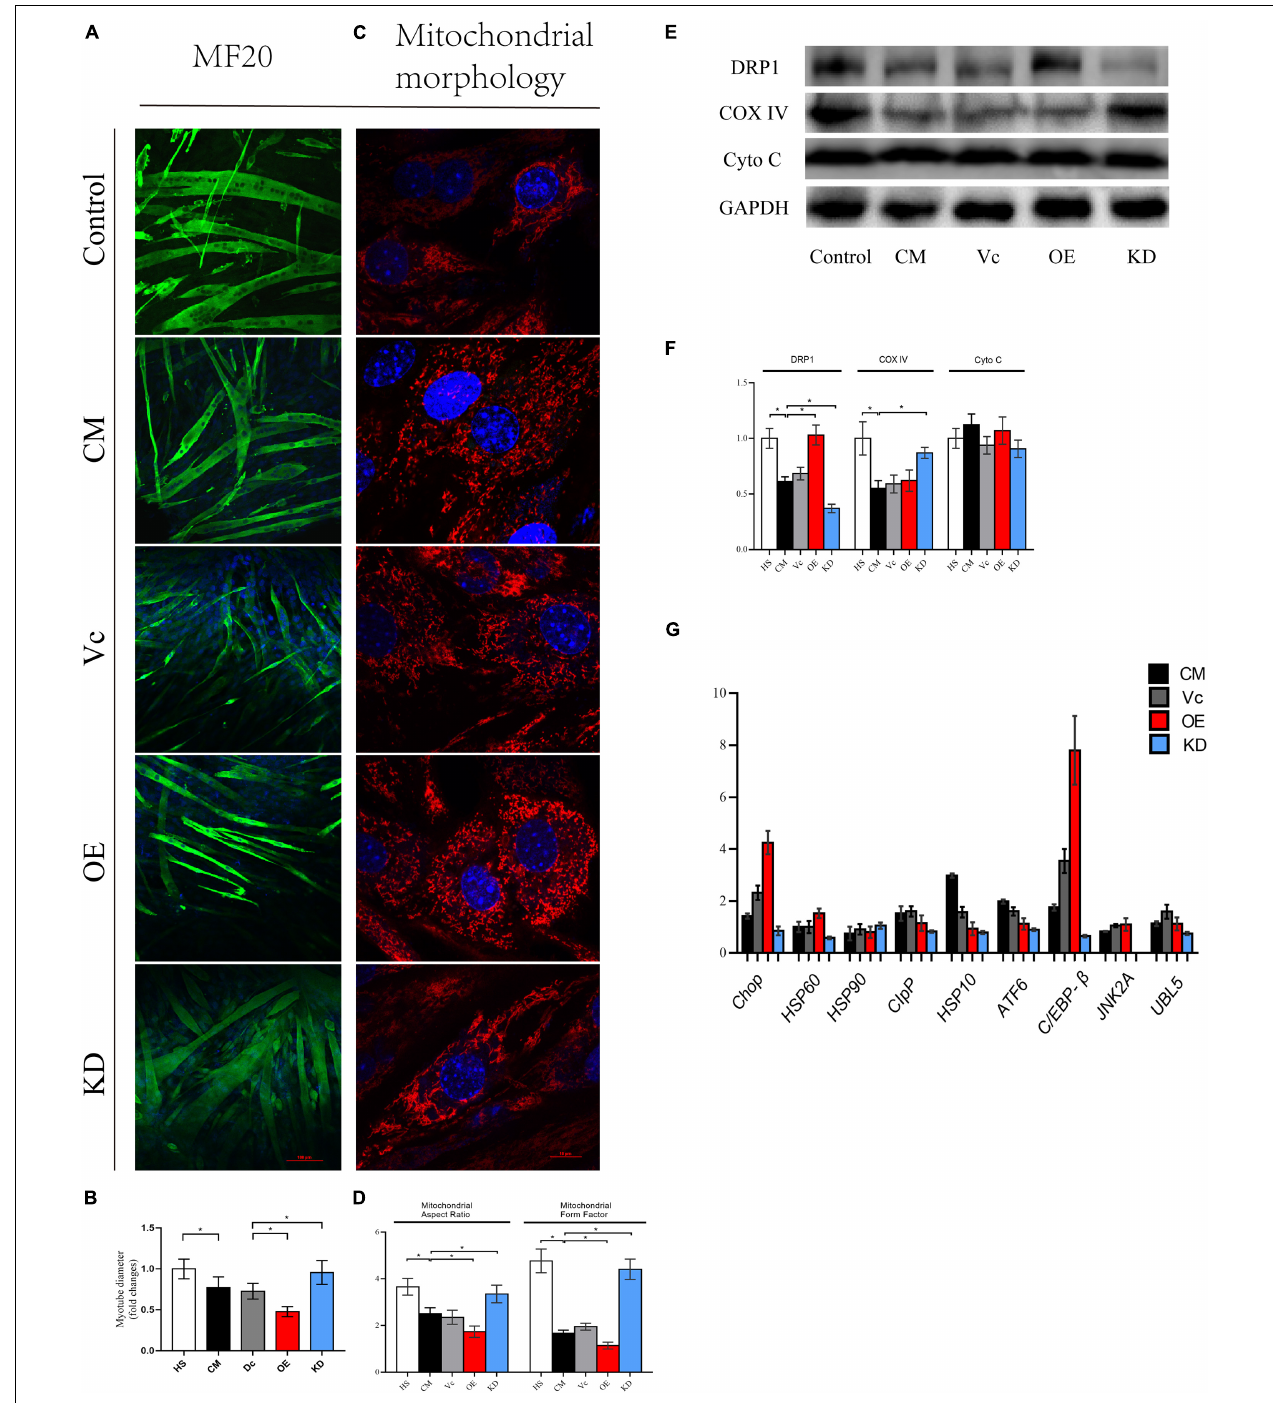
FIGURE 6 | (A) Typical images of the C2C12 myotube cocultured with CM for 48 h. Myotube was stained with MF20. (B) Quantification of myotube diameter. (C) Typical images to analyze mitochondrial morphology by MitoTracker Red CMXRos. (D) Quantification of mitochondrial morphology by Mitochondrion Analyzer, a plugin of ImageJ software. FF (form factor: the reciprocal of circularity value) and AR (aspect ratio: major axis/minor axis of an ellipse equivalent to the object) (E) Level of DRP1, Cyto C, COX IV, and GAPDH by Western blot. (F) Quantification of DRP1, Cyto C, COX IV, and GAPDH. (G) Quantification of relative genes expression of Chop , HSP60 , HSP90 , CIpP , HSP10 , ATF6 , C/EBP- β , JNK2A , and UBL5 by real-time PCR. * p < 0.05 vs. control group; # p < 0.05 vs. CM group. Data are displayed as mean ± standard deviation. Control: myotube cultured in DMEM of 2% HS CM: myotube cultured in control (2% HS), CM (myotube without infection in DMEM of 33% C26 conditional medium), Vc (myotube infected with control lentivirus in CM), OE (myotube infected with overexpressed lentivirus in CM), and KD (myotube infected with knockdown lentivirus in CM). Data are displayed as mean ± standard deviation.